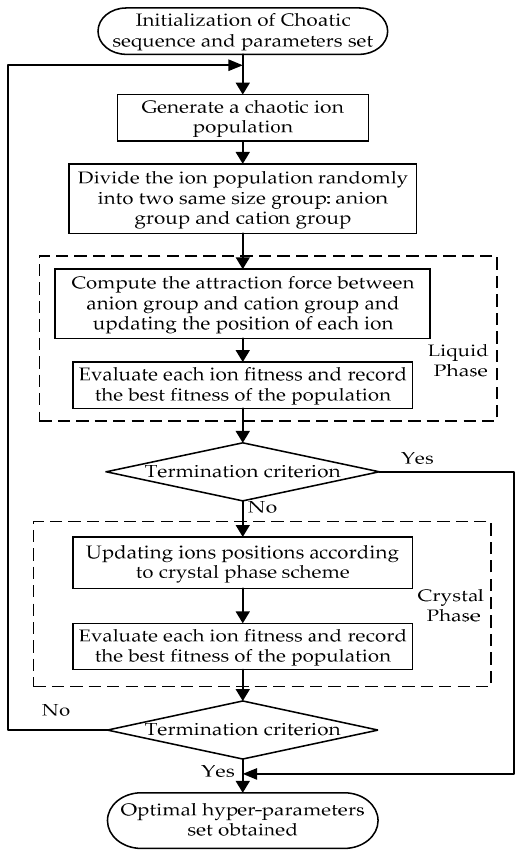
Figure 3. Chaotic ions algorithm optimized hybrid kernel least squares support vector machine (CIMA-LSSVM).